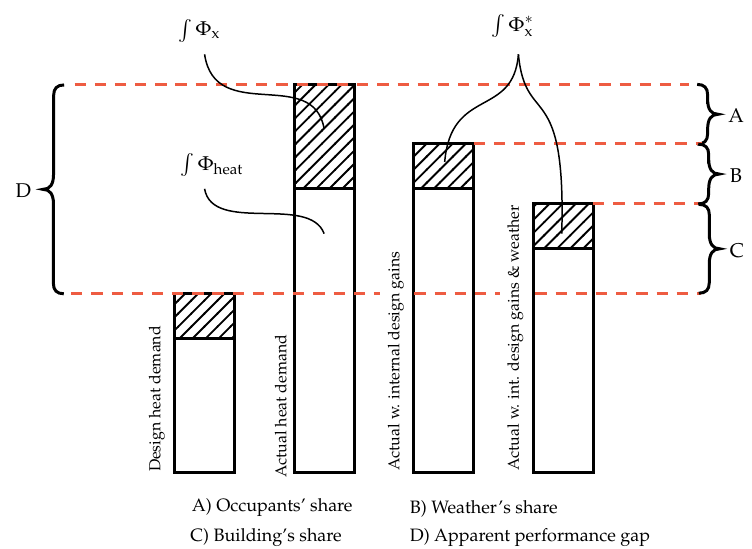
Figure 7. Conceptual illustration of performance gap and three causes of the discrepancy. Points A–C are further explained in the following list. Each column correspond to the total heat demand, and the hatched part illustrates the user related heat heat contribution to the total